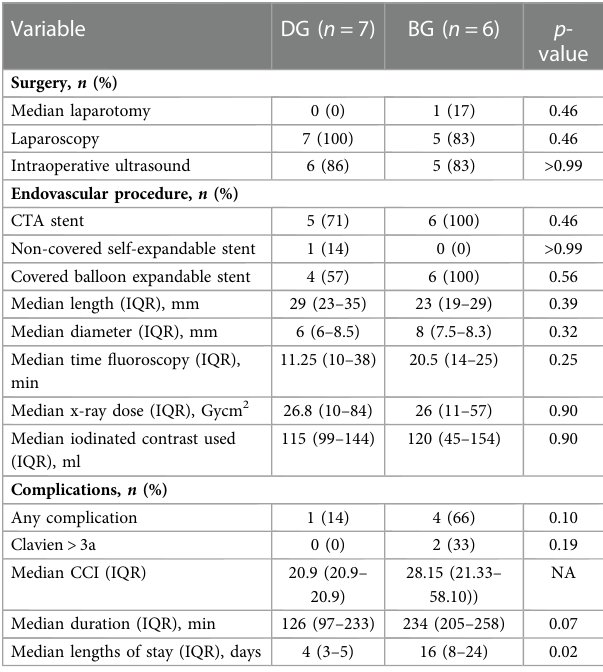
TABLE 2 Surgical details and postoperative